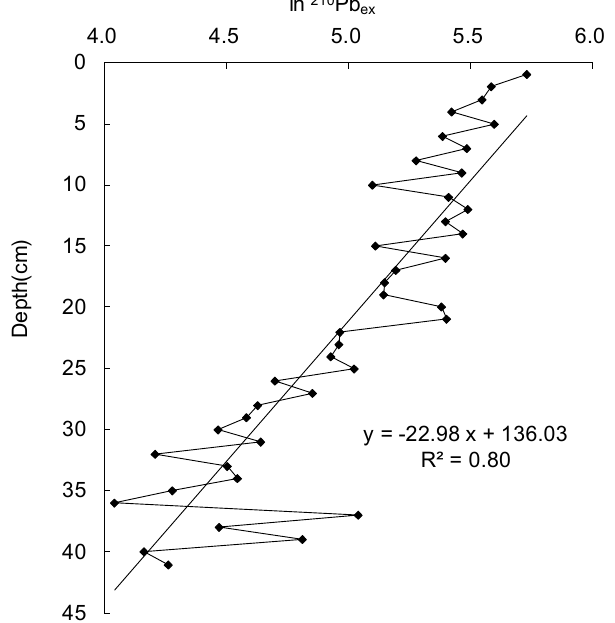
Figure 3. Log plots of 210 Pbex with its depth and its correlation in the sediment core.